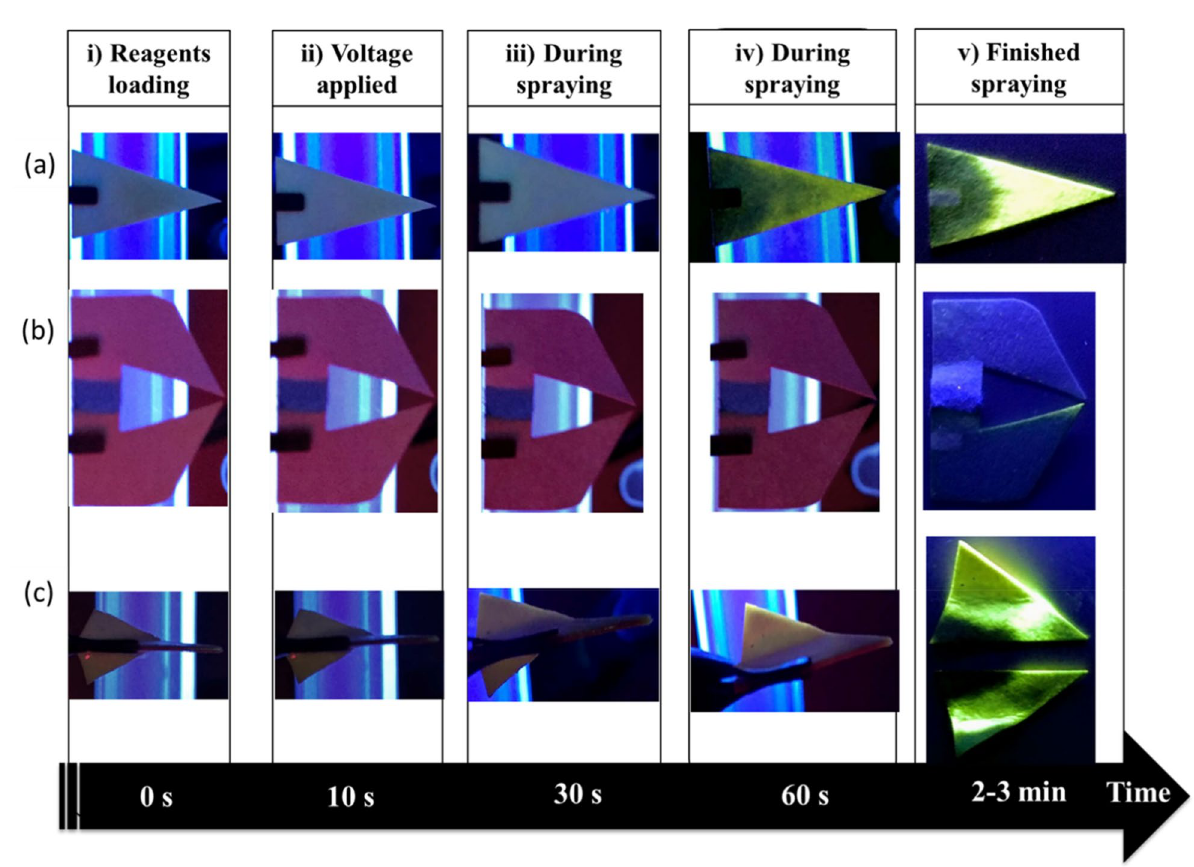
Figure 6. Flow of spraying observation over time, under UV light from each of the paper tips: ( a ) single tip, ( b ) dual-tip and ( c )